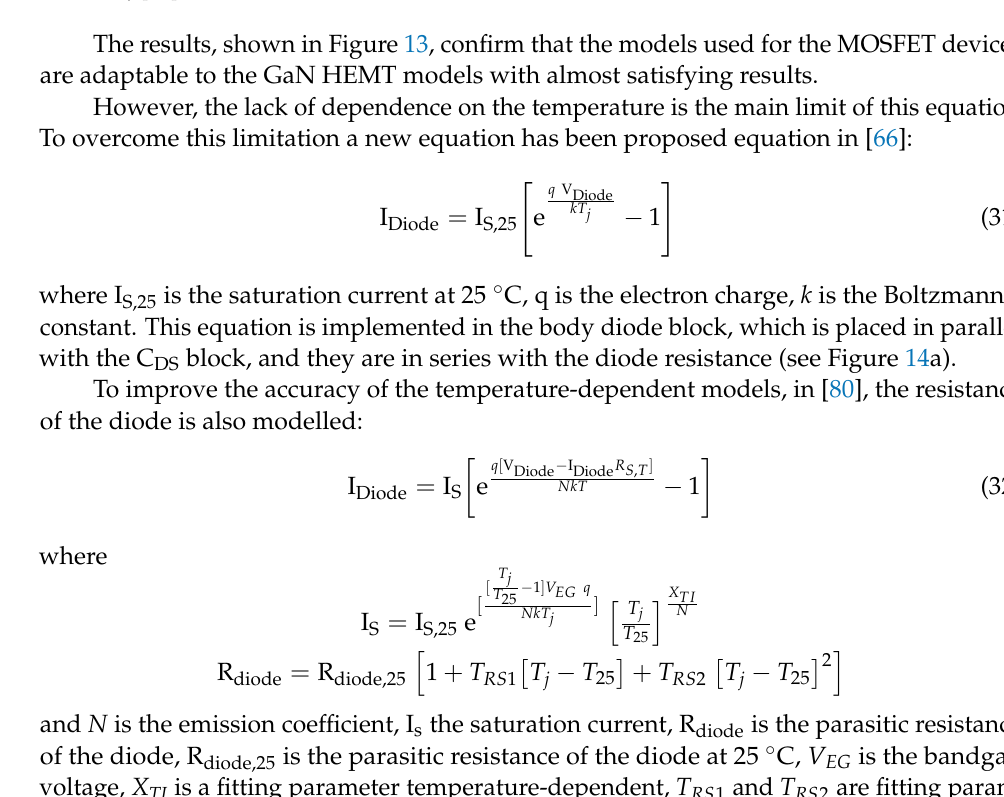
Figure 13. Comparison of third quadrant behaviour between target curves (solid lines) and simulated curves (dashed lines): ( a ) Si MOSFET (Infineon IPP60R099C6) [86]; ( b ) GaN HEMT (EPC EPC2001) [87].